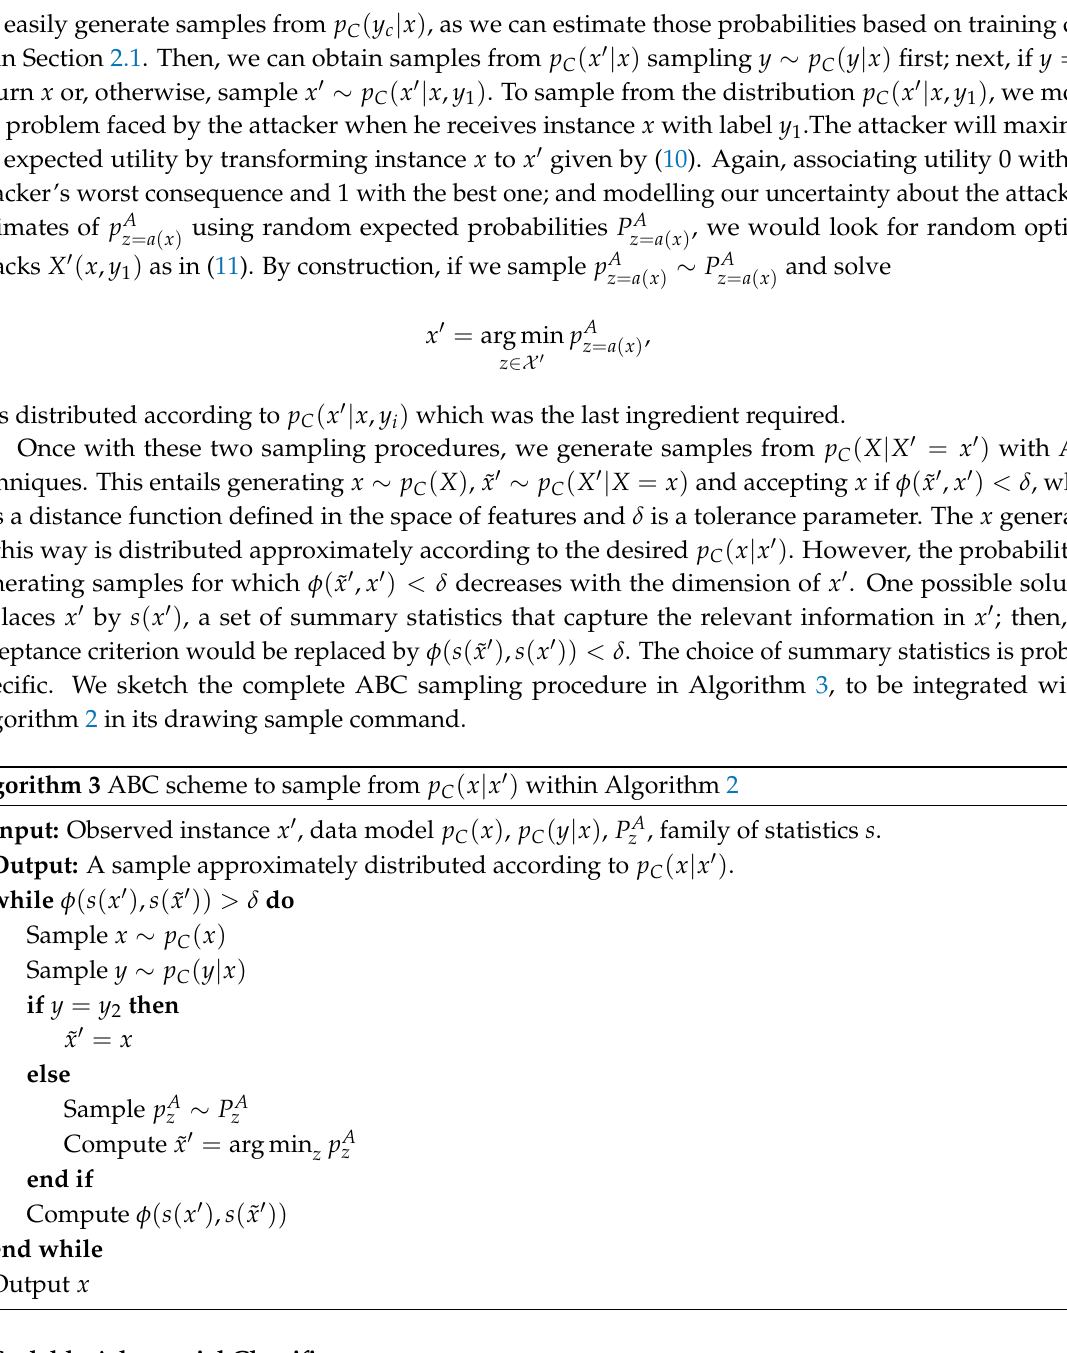
x (cid:48) ) within Algorithm |